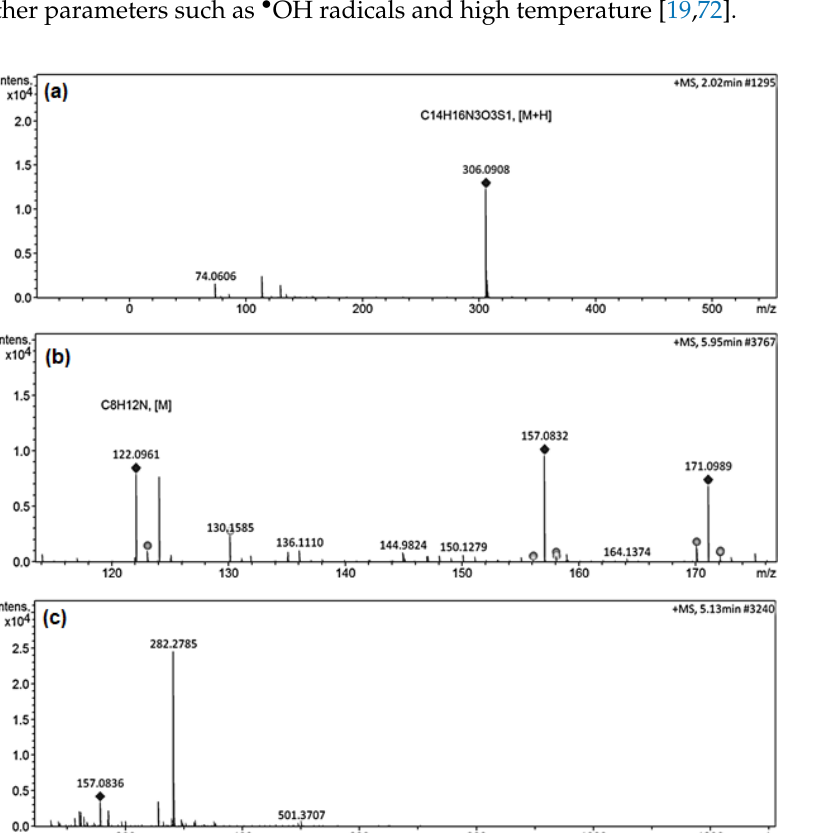
Figure 12. Possible reaction pathway of MO degradation. 3. Materials and Methods 3.1. Materials The precursor for iron nanoparticles: iron sulphate heptahydrate (FeSO 4 ·7H 2 O, ≥ 99.0%), the reducing agent: sodium borohydride (NaBH 4 , ≥ 98.0%), the surfactant polyvi- nylpyrollidone (PVP, MW 40,000), hydrochloric acid (HCl, 37.0%), and sodium hydroxide pellets (NaOH ≥ 98.0%) were all obtained from Sigma Aldrich, Johannesburg, South Af-